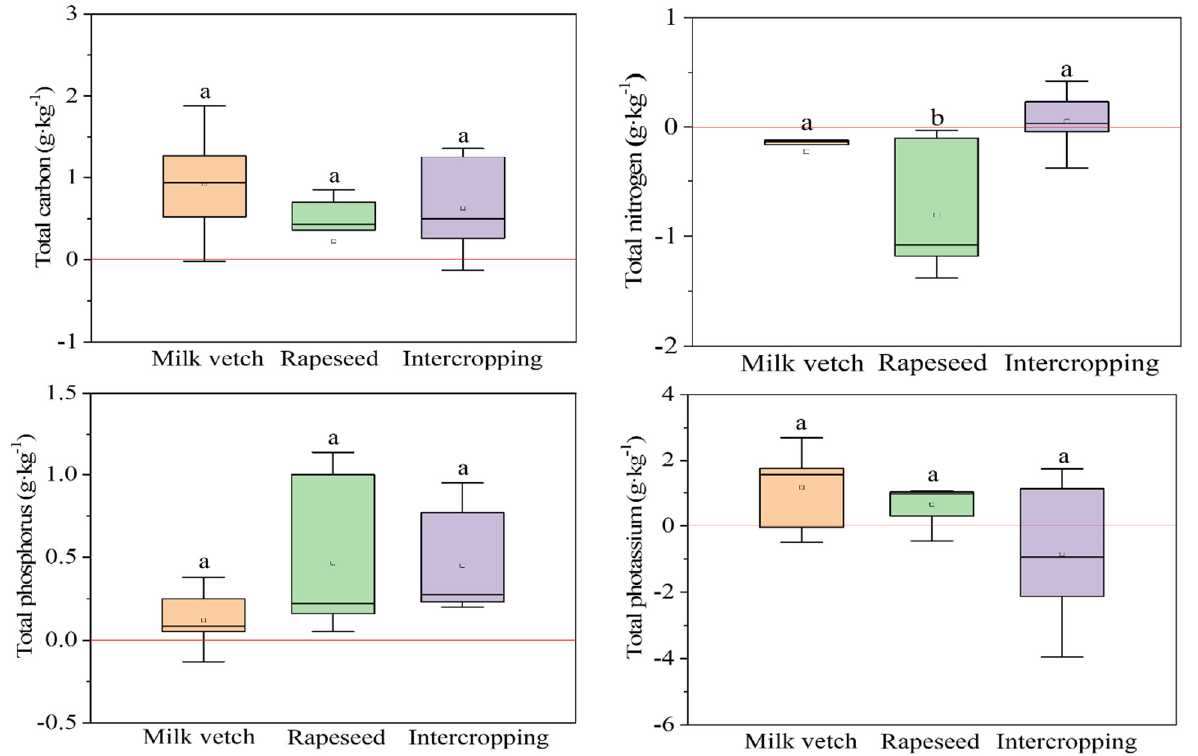
Figure 3. Content difference in soil nutrients between maturation and seedling stage. The difference in soil nutrients between maturation and seedling stage was used to represent the changes in soil nutrients with crop growth, which were analyzed by one-way ANOVA with the crops (levels: rapeseed, milk vetch, and intercropping). The visual results are displayed by box plot. The top and bottom horizontal lines of the box in the figure are the maximum and minimum values of the sample data, respectively; the upper and lower limits of the box are the upper and lower quartiles of the data, respectively; the horizontal line in the box is the median; and the small box is the mean value. Letters represent the significant differences ( p < 0.05) of soil nutrients changes between different planting